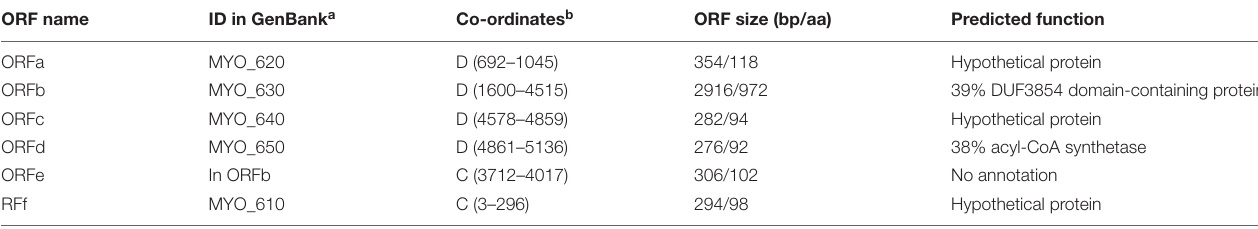
TABLE 3 | Endogenous pCC5.2 plasmid